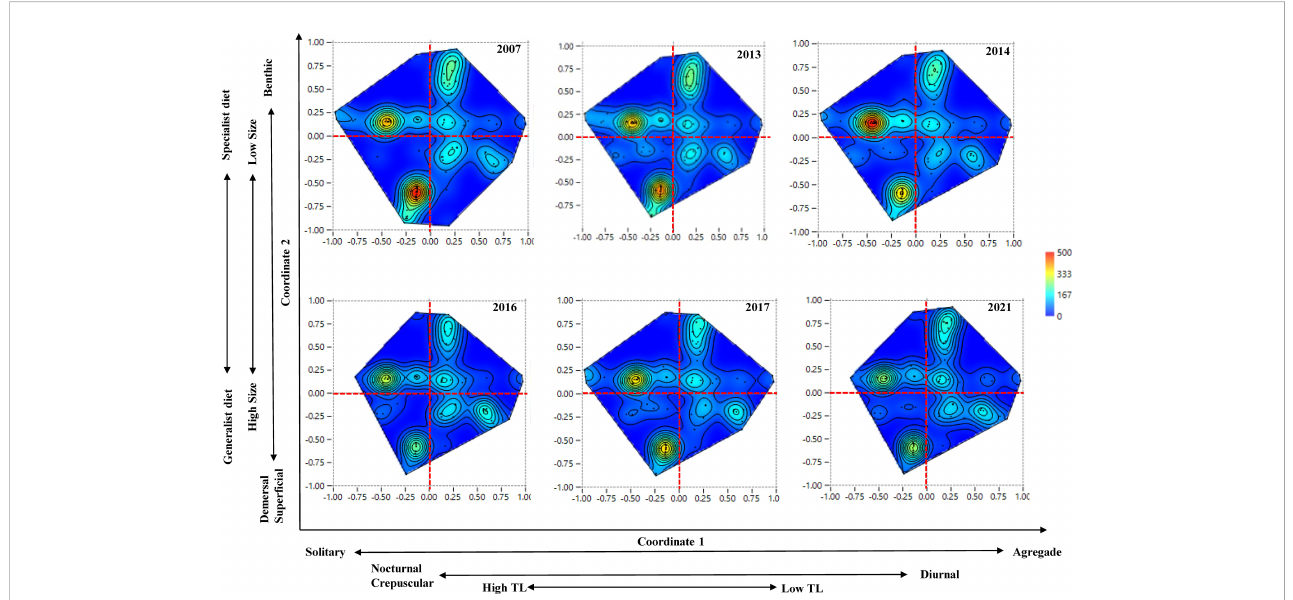
FIGURE 5 Temporal variation of functional redundancy in fi sh assemblages of the Parque Nacional Sistema Arrecifal Veracruzano (PNSAV). Maps show boundaries of the functional trait space thru time with species location in the trait space as dots, and hotspots of species with similar trophic function as reddish regions. Functional trait spaces were plotted with the fi rst two axes of the principal coordinate analysis for graphical representation where coordinate 1 and coordinate 2 explained 23.98% and 22.57% of the cumulative total variation respectively. The scale bar gives an estimate of the number of species per area based on species distances within a radius of 0.097 within the trait functional space. Gradients of functional traits are shown for the fi rst and second coordinate axes only for this graphical